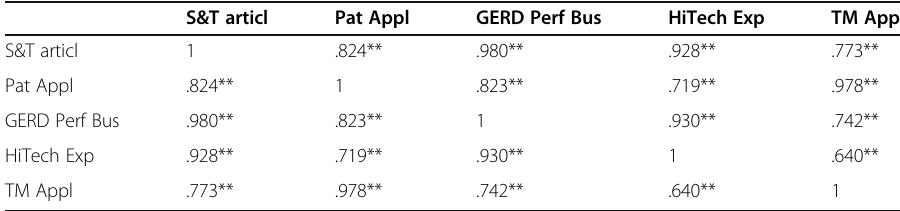
Table 3 Correlations matrix